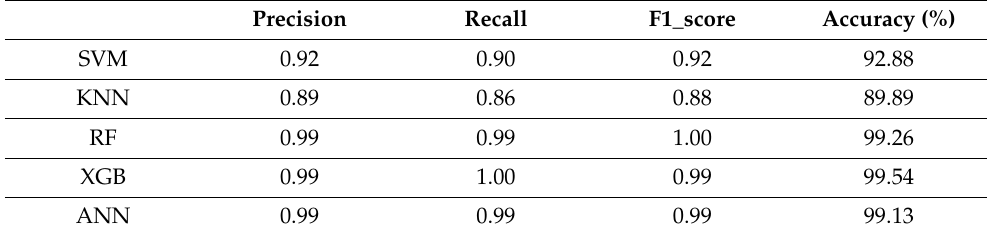
Table 5. The resultant evaluation parameters.